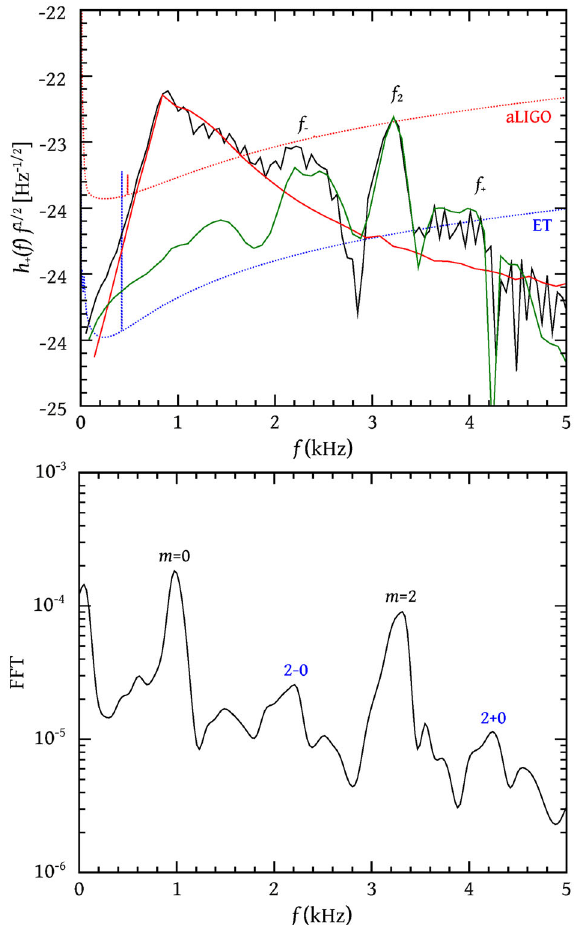
Fig. 33 Top panel : Total (black), pre-merger (red) and post-merger (green) scaled power spectral density, compared to the aLIGO and ET unity SNR sensitivity curves for a HMNS formed in the merger of an equal mass NSNS system using the Lattimer–Swesty (LS). Each neutron star has a mass of 1 . 35 M (cid:3) and the distance to the source is set at a nominal value of 100 Mpc. Lower panel : Corresponding FFT of the evolution of pressure in the equatorial plane, where discrete oscillation frequencies and their quasi-linear combinations can be seen. (Image reproduced with permission from Stergioulas et al. 2011, copyright by the